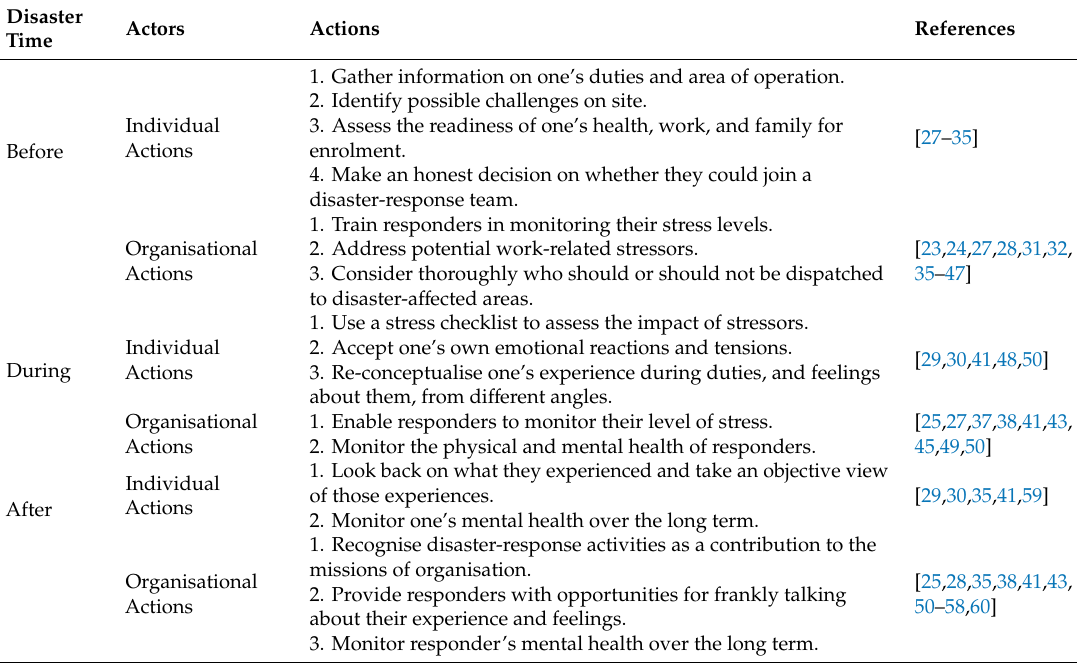
Table 1. Actions for Goal 1: Understanding stressors and making them